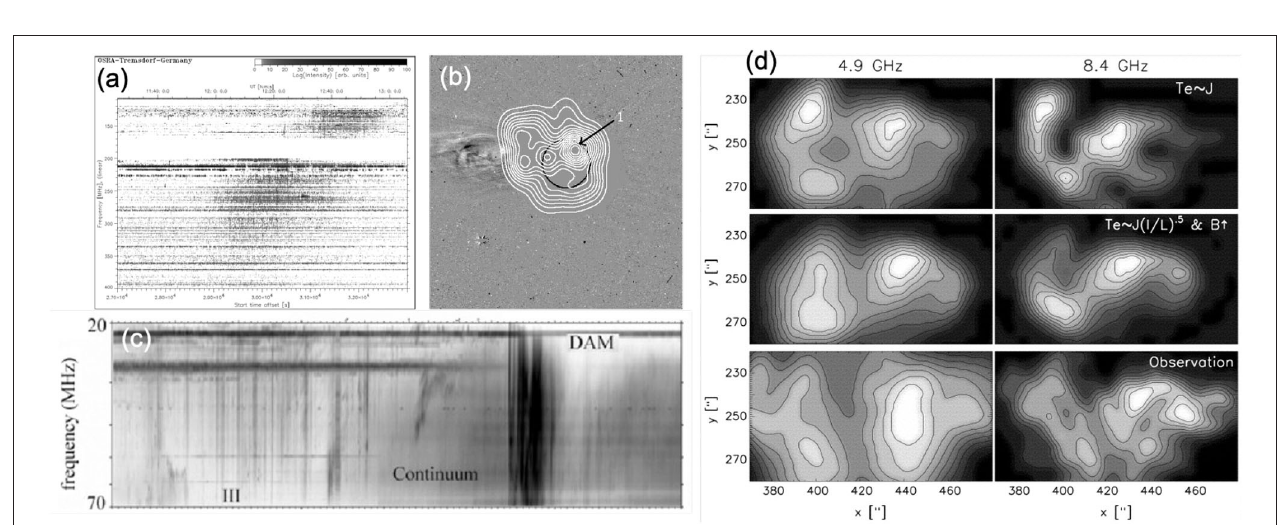
FIGURE 1 | Dominant radio emission mechanism vs. heliocentric distance based on model plasma parameters of temperature, density, and magnetic field strength. f p are the plasma frequency, f B is the gyrofrequency, and f τ = 1 is the frequency where free-free emission becomes optically think. For details on these quantities and physical mechanisms (see Alissandrakis et al., 2020; Nindos et al., 2020). The plot is available here (Courtesy D. Gary).